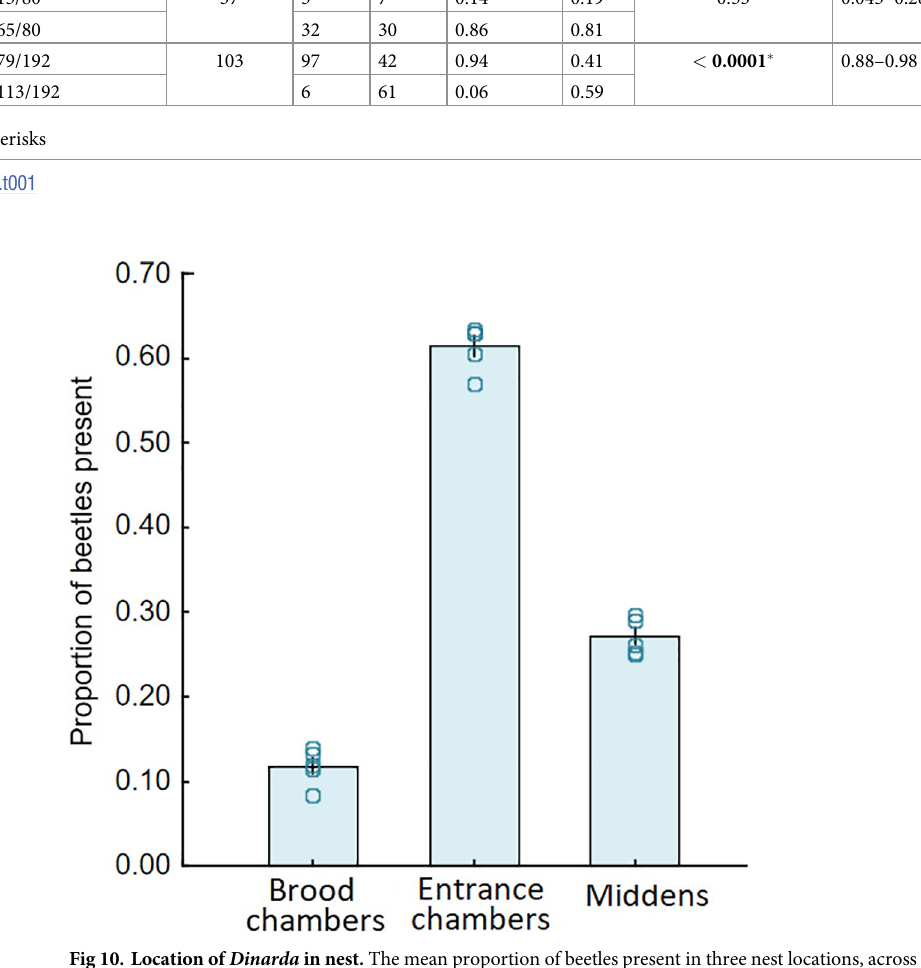
Fig 10. Location of Dinarda in nest. The mean proportion of beetles present in three nest locations, across five colony averages (bars represent the standard error of the mean). Less than 12% of beetles were found in brood chambers. Most beetles were found inside entrance chambers (mean proportion = 0.61, SD 0.03), followed by middens (0.27, SD 0.02).